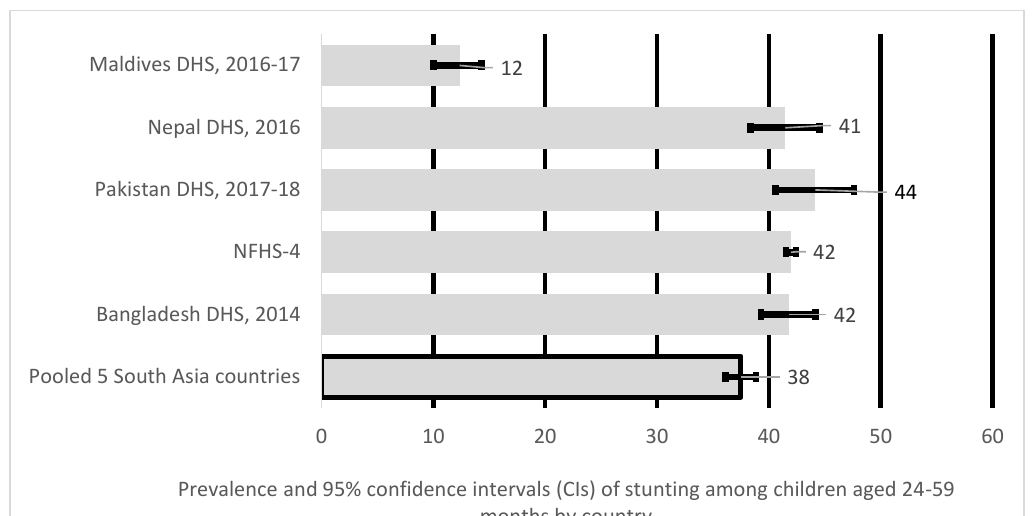
Figure 3. Prevalence and 95% confidence intervals (CIs) of stunting in children aged 24–59 months in South Asia.